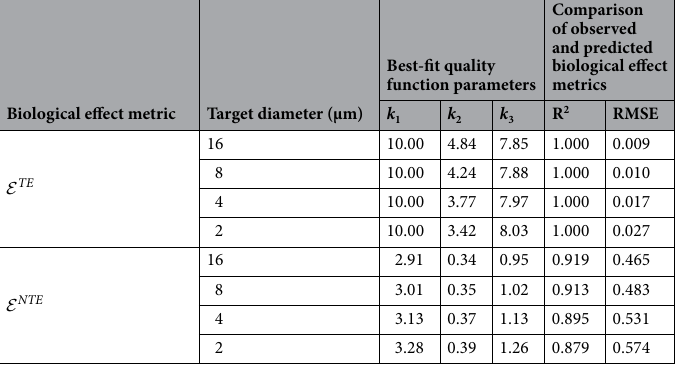
Table 2. Best-fit parameter values for low doses from the radiation quality functions of lineal energy q ɛ ( y ) TE NTE for the E and E metrics, for each spherical target diameter. Agreement between observed and best-fit predicted relative biological effect metrics over all radiation types was assessed by R 2 and RMSE.